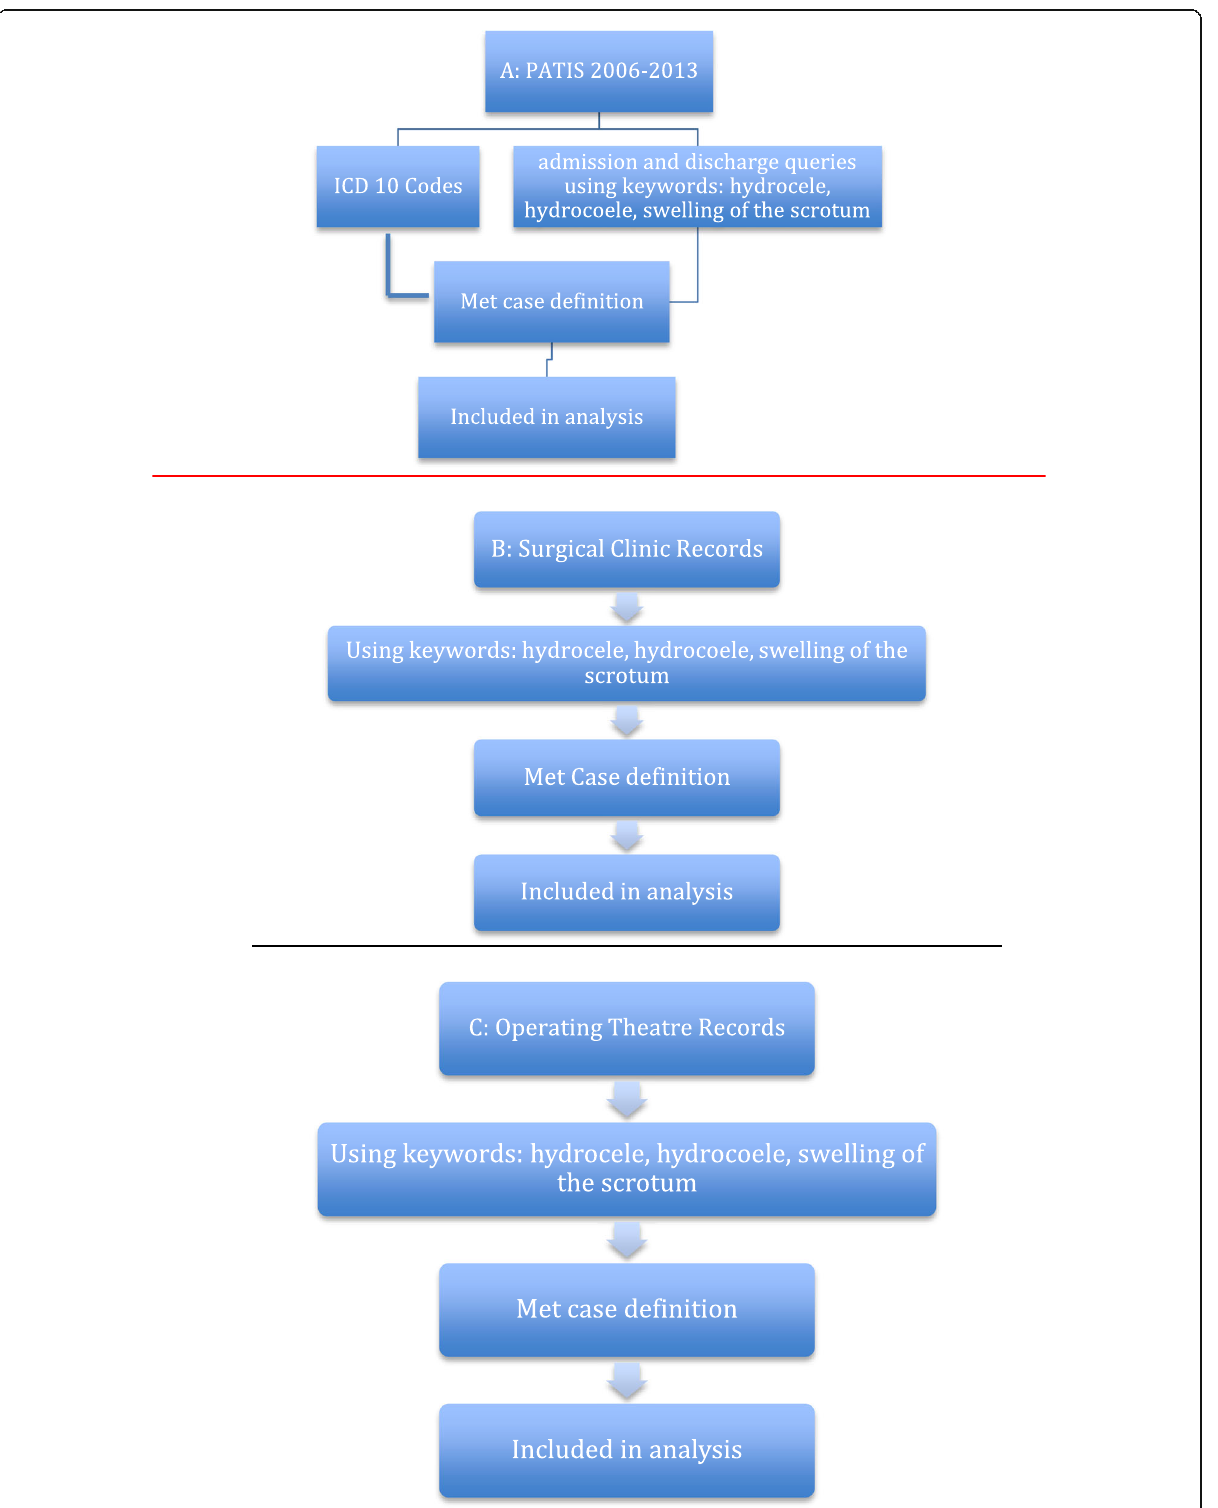
Fig. 4 Study methodology and sources of information on cases. A PATIS information system. B Surgical clinic records. C Operating theater